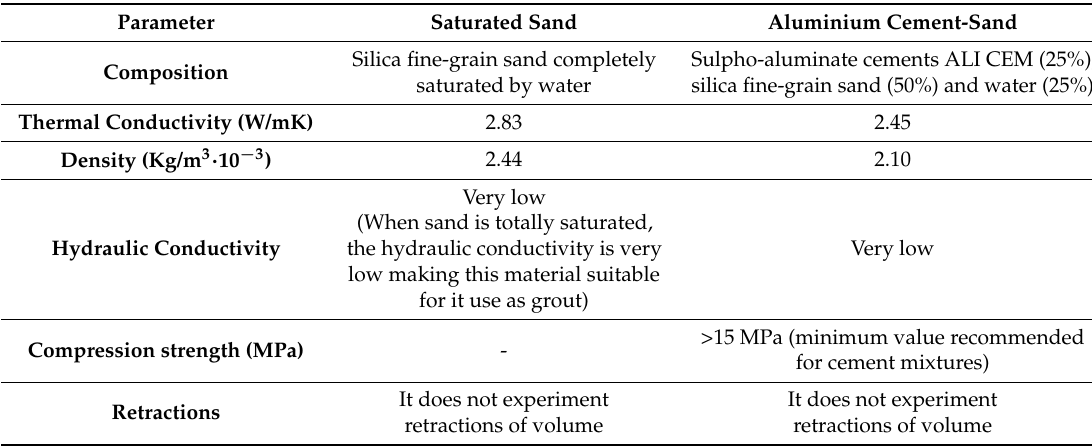
Table 2. Main characteristic of the materials chosen to be used as